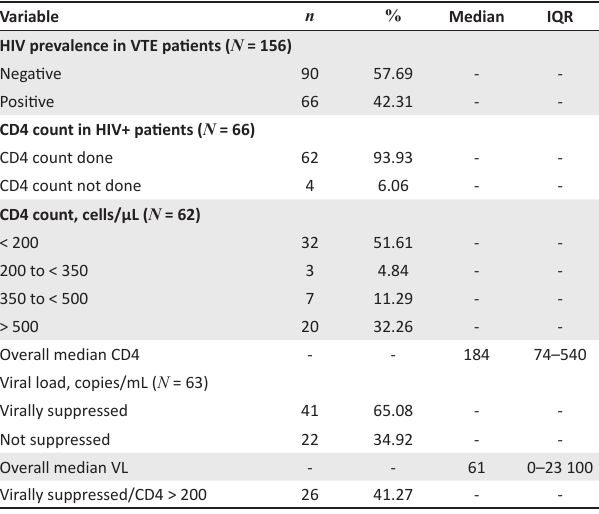
TABLE 5 : Summary of the CD4 and viral load results obtained for patients with venous thromboembolism in this study.